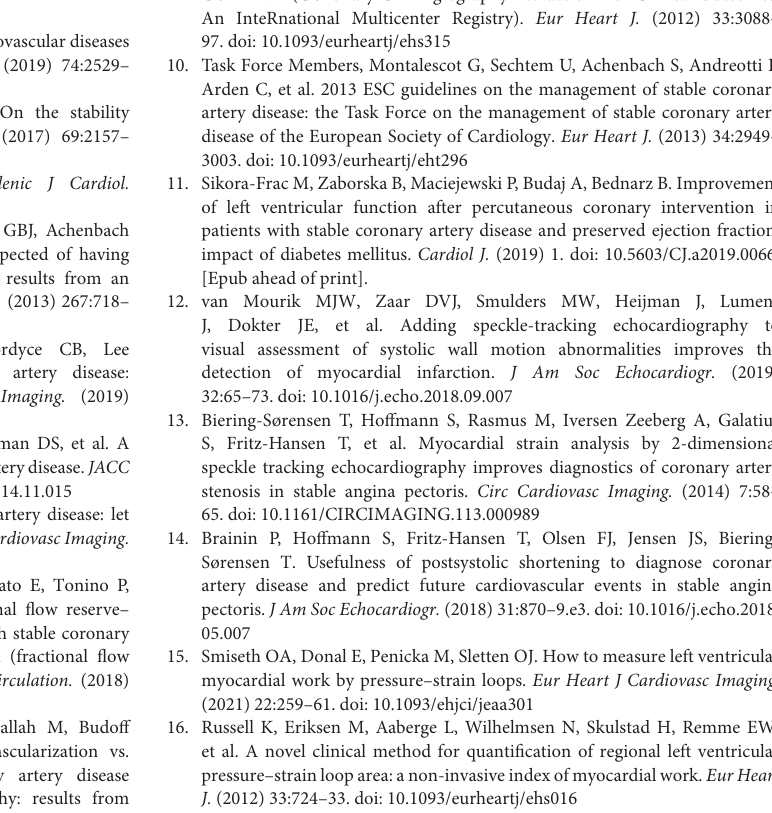
Supplementary Figure 1 | Step wise calculation of various MW parameters. (A) Global longitudinal strain and segmental longitudinal strain displayed as bull’s eye diagram were obtained using automated functional imaging. (B) Timing of aortic and mitral valve opening and closing events was confirmed on two-dimensional echocardiography, and brachial cuff systolic pressure was input. (C) The pressure-strain loop, various MW parameters, and bull’s eye diagram of